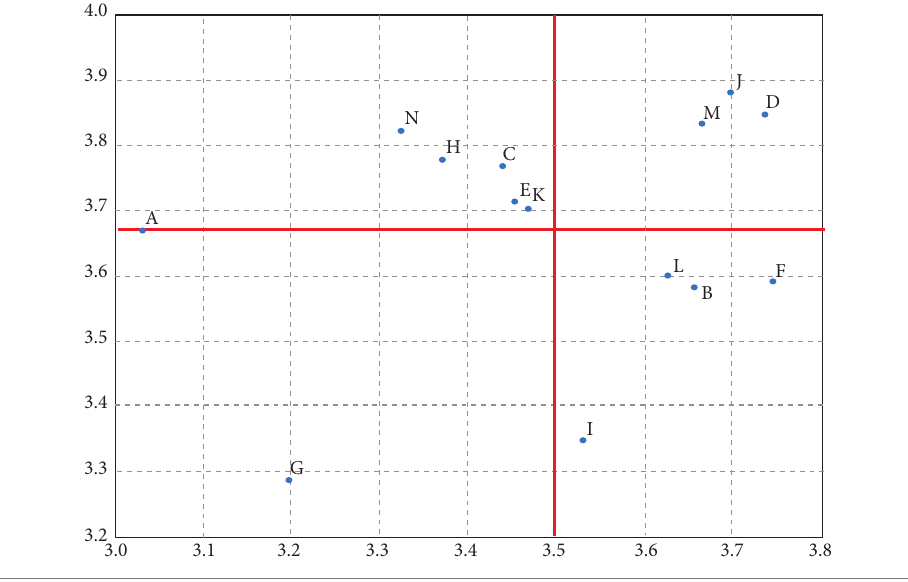
Fig. 11. The scatter diagram of parameters of relations of Slovak enterprises with the subcontractor/main contractor